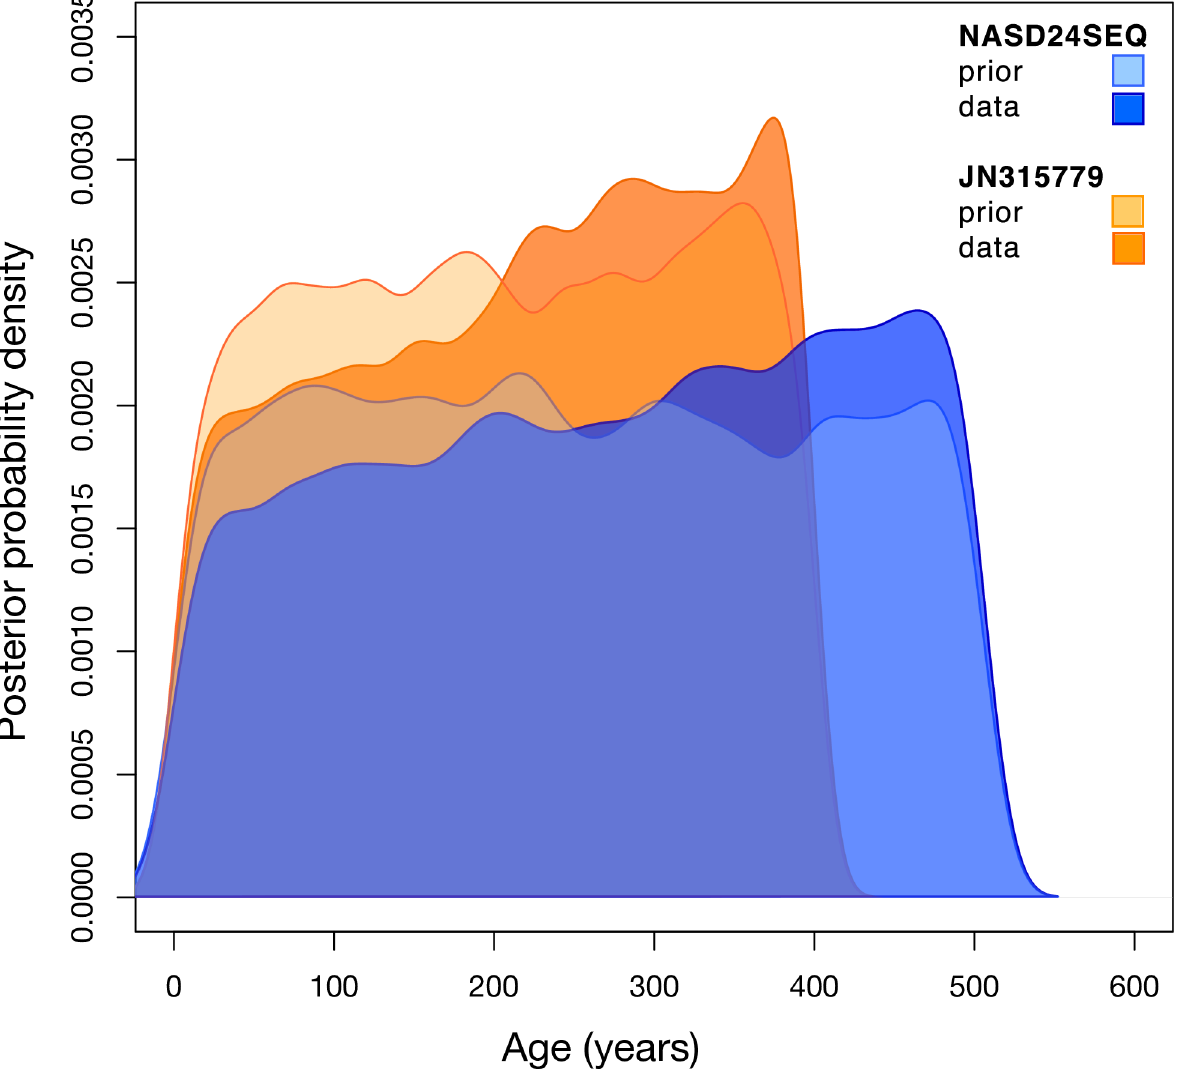
Fig 7. Comparison of prior and posterior probability distribution estimatesfor the age of ancient HBV samples NASD24SEQ and JN315779. Histogramshowingthe probabilitydensity estimationdistributions for the Bayesiananalysisof NASD24SEQ and JN315779both with and without sequencedata from subset a-ii, using a normal prior approximating the radiocarbondates for the samples and with the internalcalibrationscheme using the estimationof entry into the Americas from Llamas et al. 2016 [55] to calibrate the node separating genotypesF and